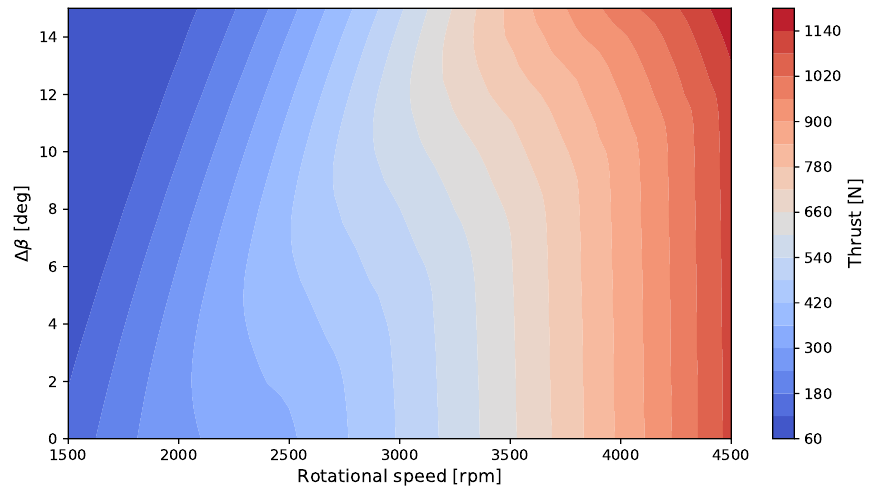
Figure 13. Sensitivity of the thrust to changes in rpm and pitch angle of the blade in the off-design analysis